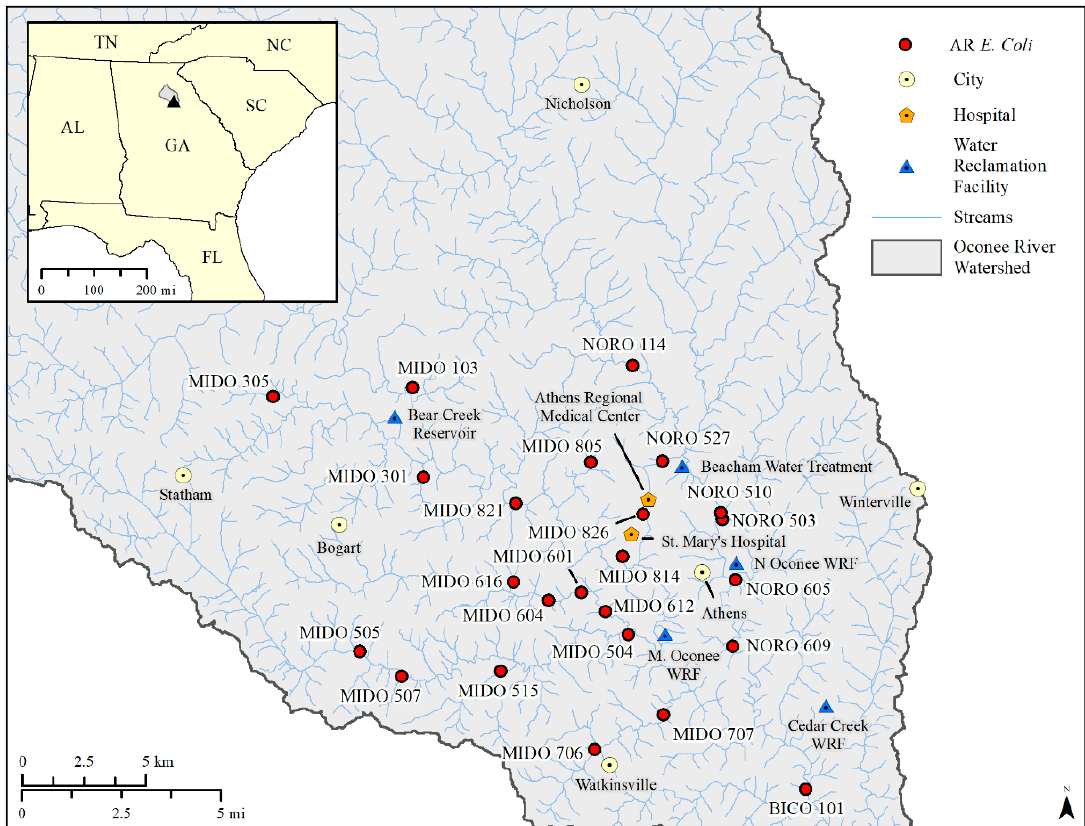
Figure 1. Map of water sampling sites in the Upper Oconee Watershed near Athens, GA. Sampling sites where antimicrobial resistant E. coli were isolated are labeled and are symbolized as red circles. Points of interest (circles—cities, triangles—water reclamation facilities, and pentagons—hospitals) are also labeled. The National Hydrography Dataset (NHD) streams are shown for reference. Inset map shows the Upper Oconee watershed in grey and Athens, GA, as a black triangle.